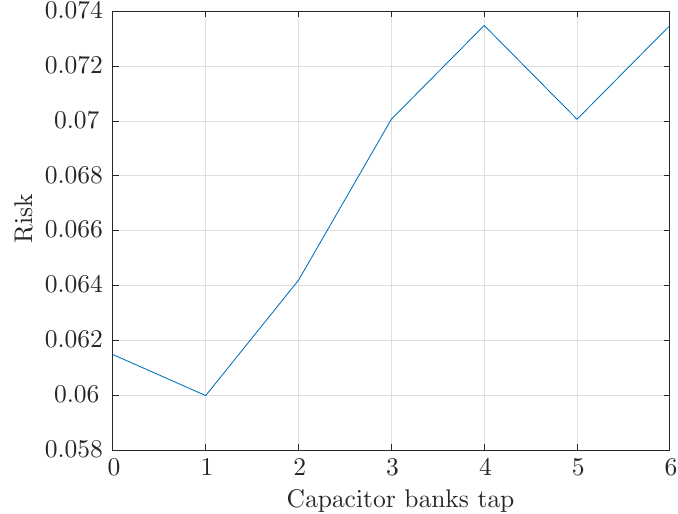
Figure 12. PQ diagram violations risk as a function of capacitor banks tap